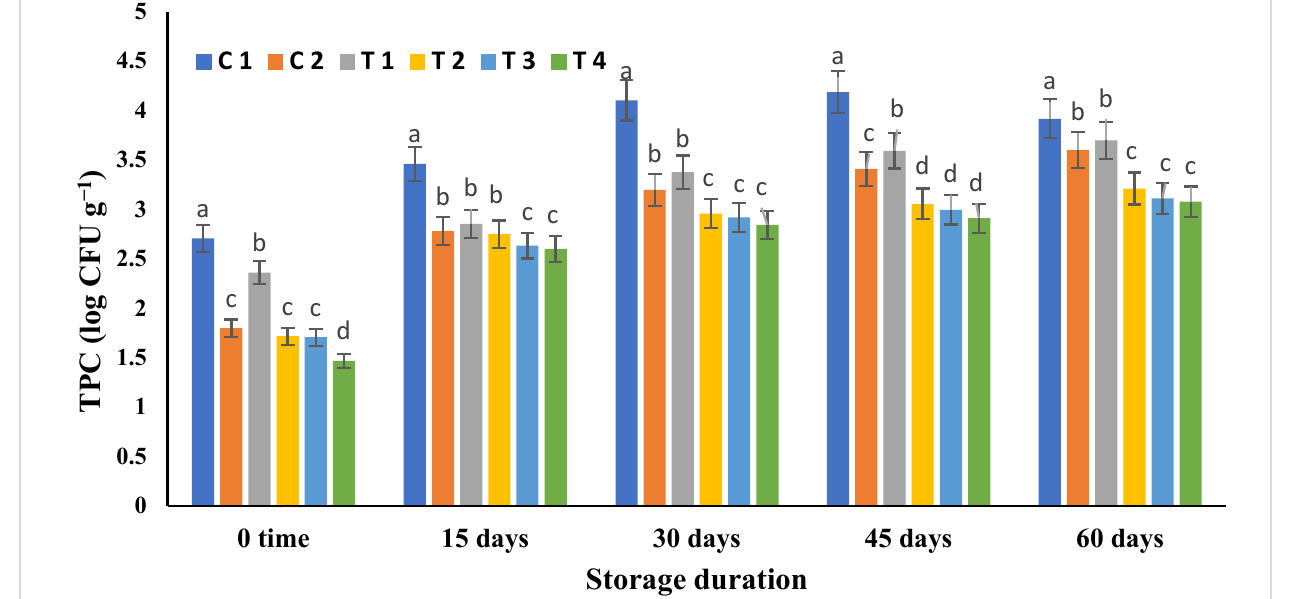
Figure 3. Microbial analysis of mayonnaise samples enriched with the RCFE during storage. Means with the same letter in columns are not statistically significant ( p ≤ 0.05), whereas means sharing a different letter in columns of the table are significantly statistical ( p ≤ 0.05). TPC, total plate count; C1, mayonnaise with no antioxidants; C2, mayonnaise treated by 0.02% BHT; T1, T2, T3, T4: mayonnaise treated by 0.125, 0.25, 0.5, and 0.75 % ethanolic Rosa canina extract, respectively.